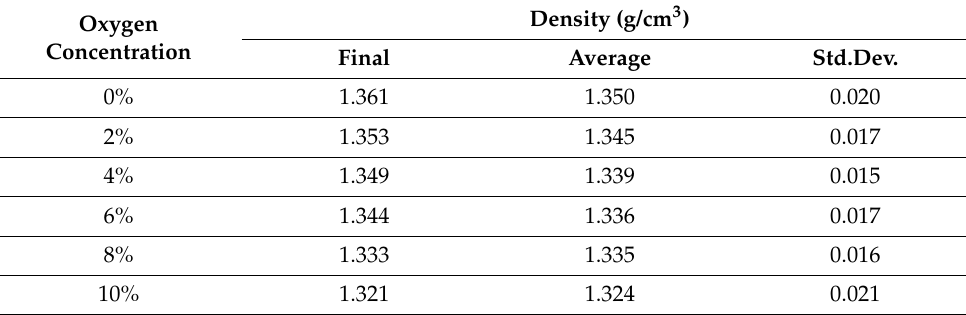
Table 4. Density of the cellulose-water-oxygen